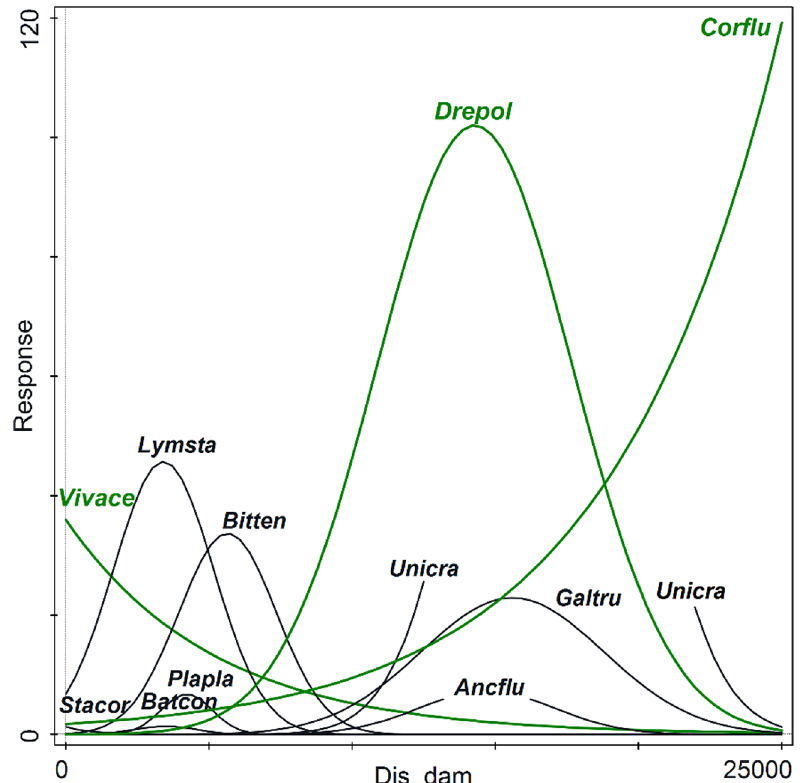
Figure 5. Species response curves to the Dis_dam: distance (in m) to dams (count data, generalized linear models, only a selection of significant models illustrated; the model parameters are given in Table S2; alien species are depicted in